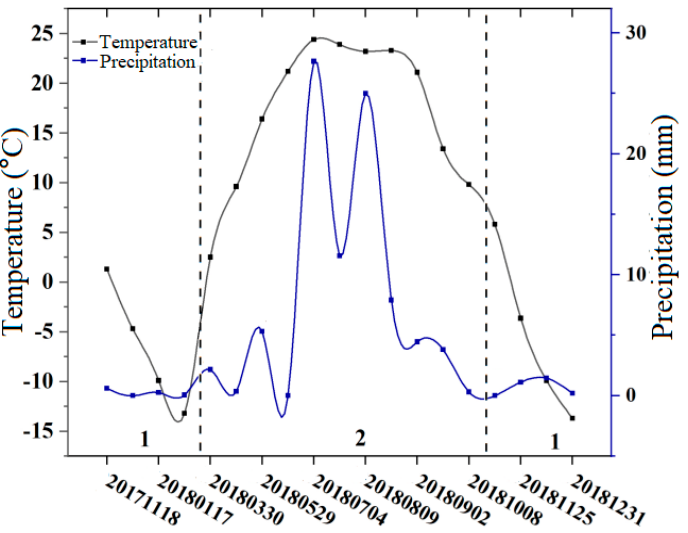
Figure 8. Temperature and precipitation in the study area. Period 1 refers to winter and Period 2 refers to summer.